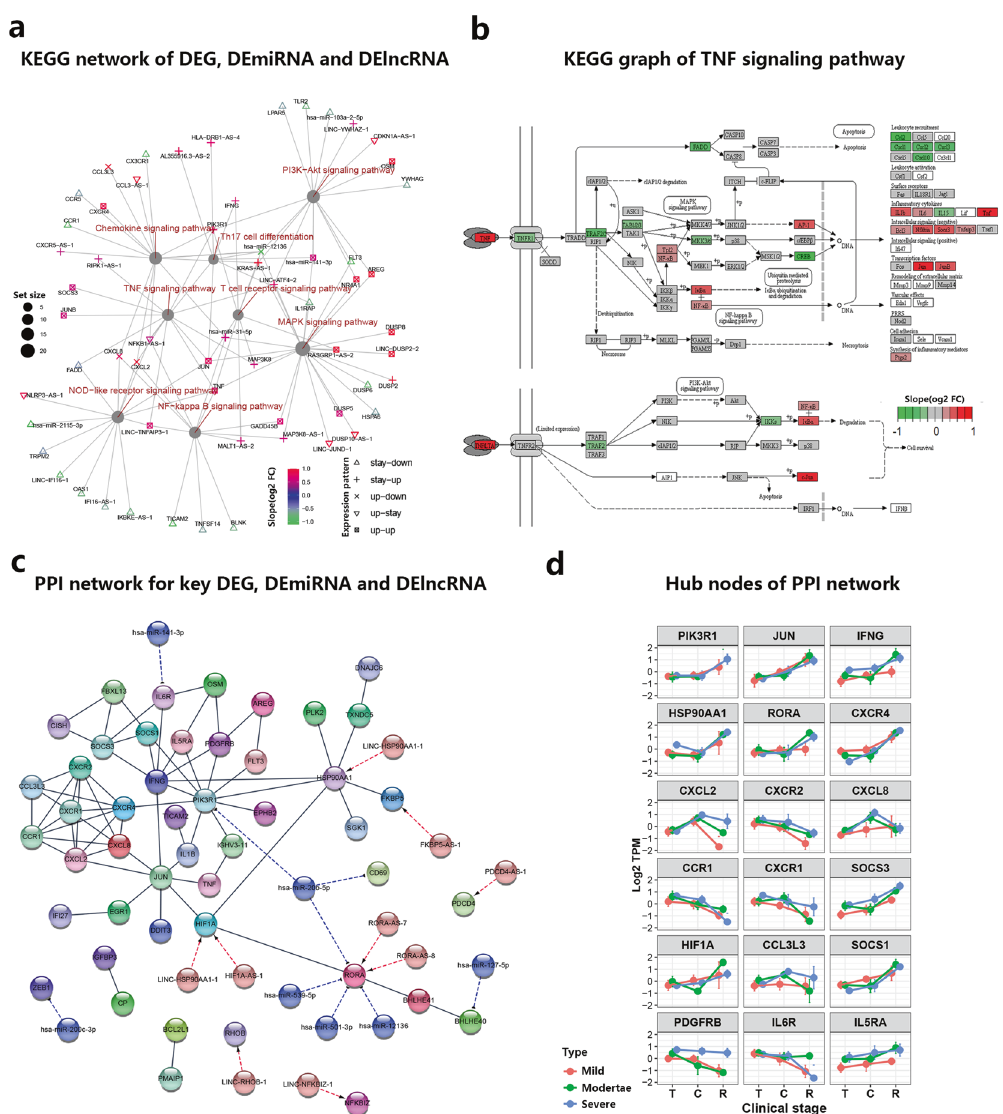
Fig. 5 Gene function network revealed a core role of the AP-1 linked signaling pathways during the recovery of COVID-19. a A network showing the relationship between genes and enriched KEGG pathway. The genes displayed are selected from the DEGs and the genes regulated by DEmiRNAs or DElncRNAs with a more signi fi cant differential expression and a higher connectivity. The color maps the linear regression slope of Log 2 fold change of a gene. The size of the circle is proportional to the number of genes enriched in a KEGG pathway. b A KEGG graph showing the interactions of genes involved in the TNF signaling pathway. The color indicates linear regression slope of Log 2 fold change of a gene. c A protein – protein interaction network (PPI) showing the interactions between genes and non-coding RNA. The genes displayed are selected from the top hub genes with the most signi fi cant differential expression. d A line graph showing the expression pro fi les of the main hub genes during COVID-19 recovery. The color indicates samples with different clinical types. T, treatment stage; C, convalescence stage; R, rehabilitation stage. The data are shown as mean ±